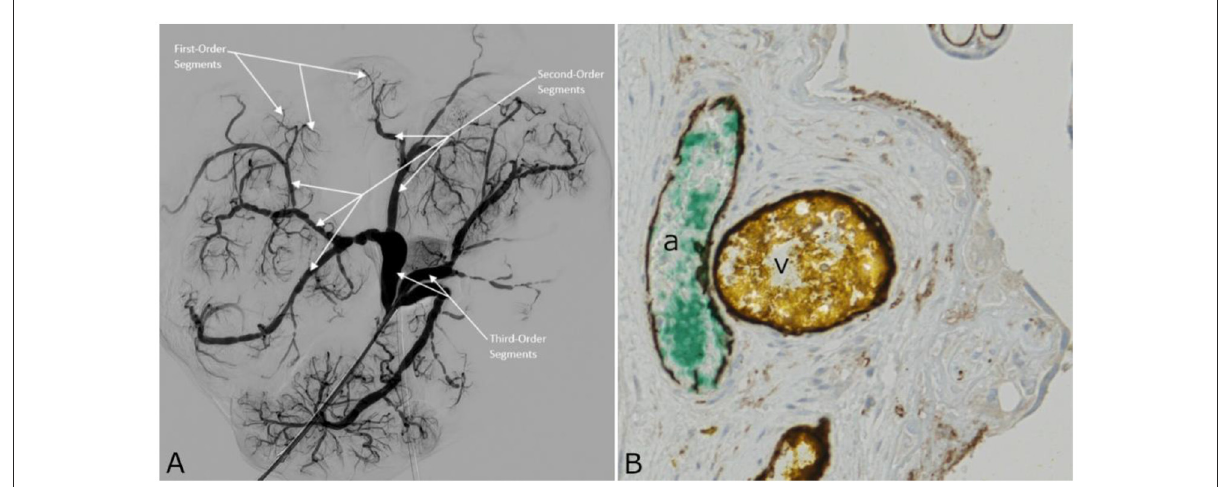
FIGURE2 (A) 2D-Angiography of the chorionic plate veins with white arrows indicating first-, second-, and third-order segments. (B) Cross sectional image of the placenta shown in Figure 1A, obtained by light microscopy. The tissue sample was stained with CD31 for endothelium. Both CPA (a) and CPV (v) endothelia are CD31 positive, and appear in dark brown.